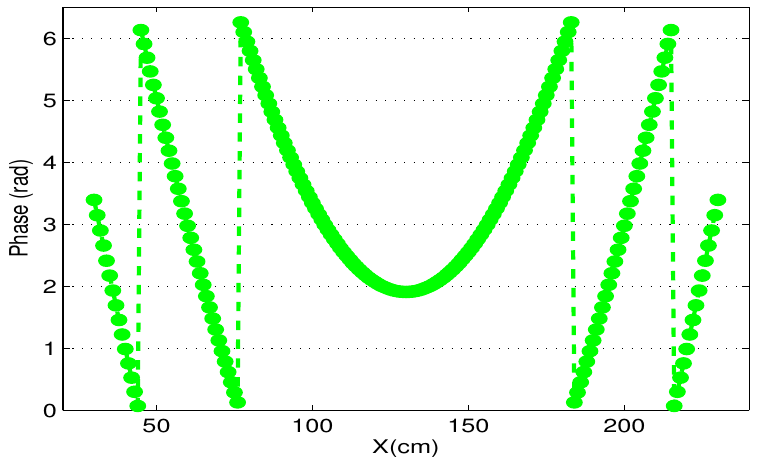
Figure 5. The wrapped phase